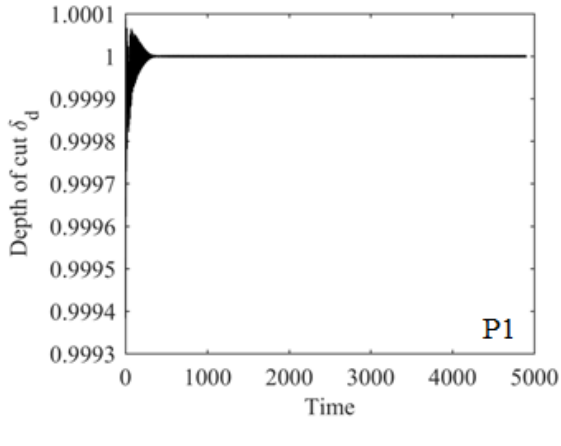
Fig. 8. Time histories for stable grinding